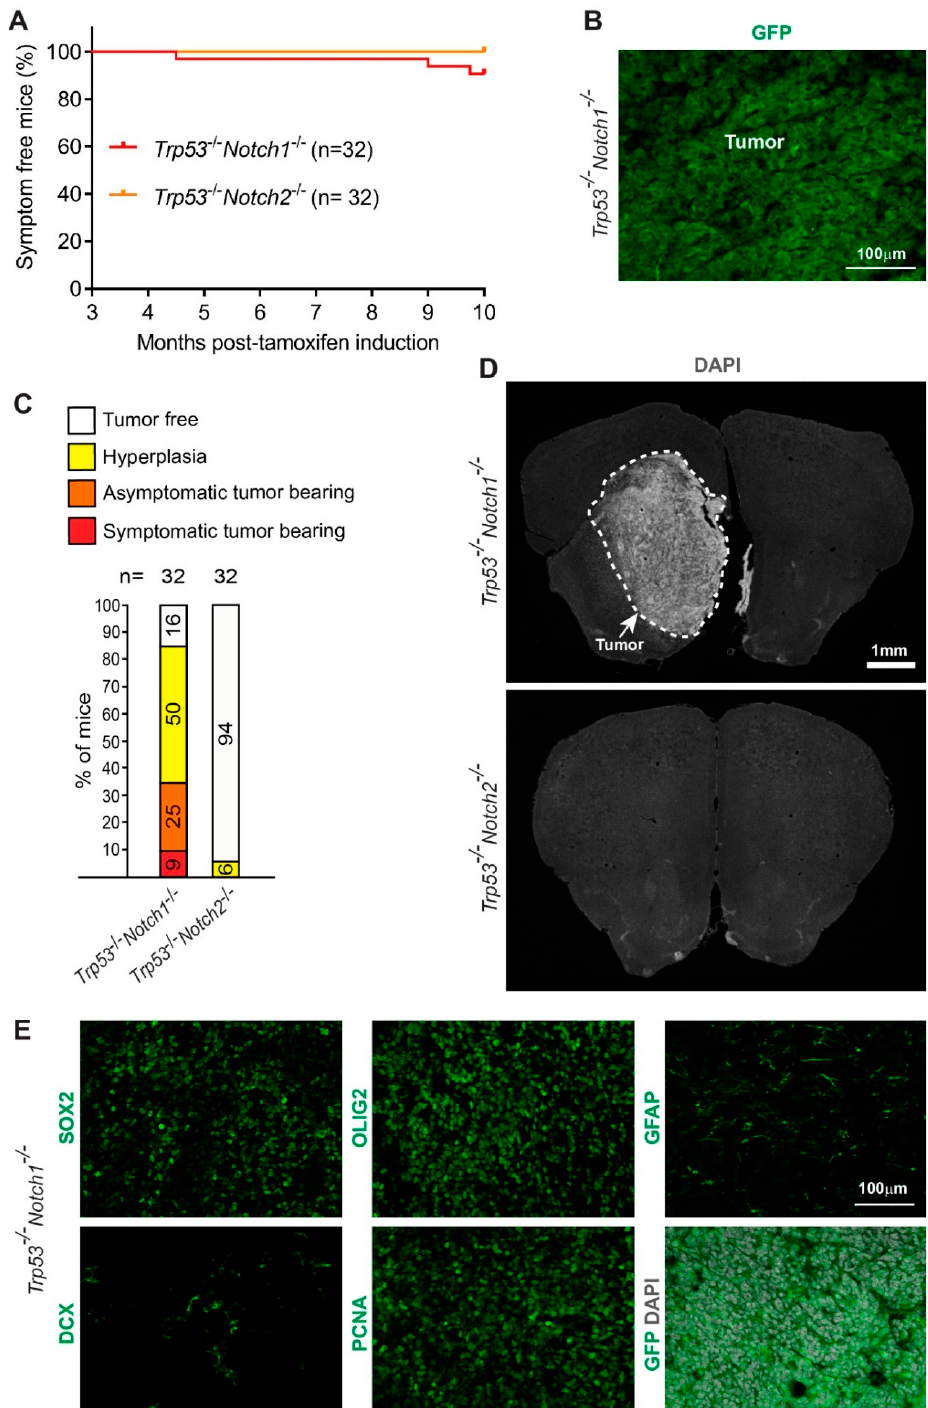
astrocytic (GFAP) and neuronal (DCX) markers, and were highly proliferative (Figure 3E, Table 1). We concluded that Notch1 and Trp53 deletion in Hes5 + cells is sufficient to induce tumor or hyperplasia formation in the forebrains of adult mice.